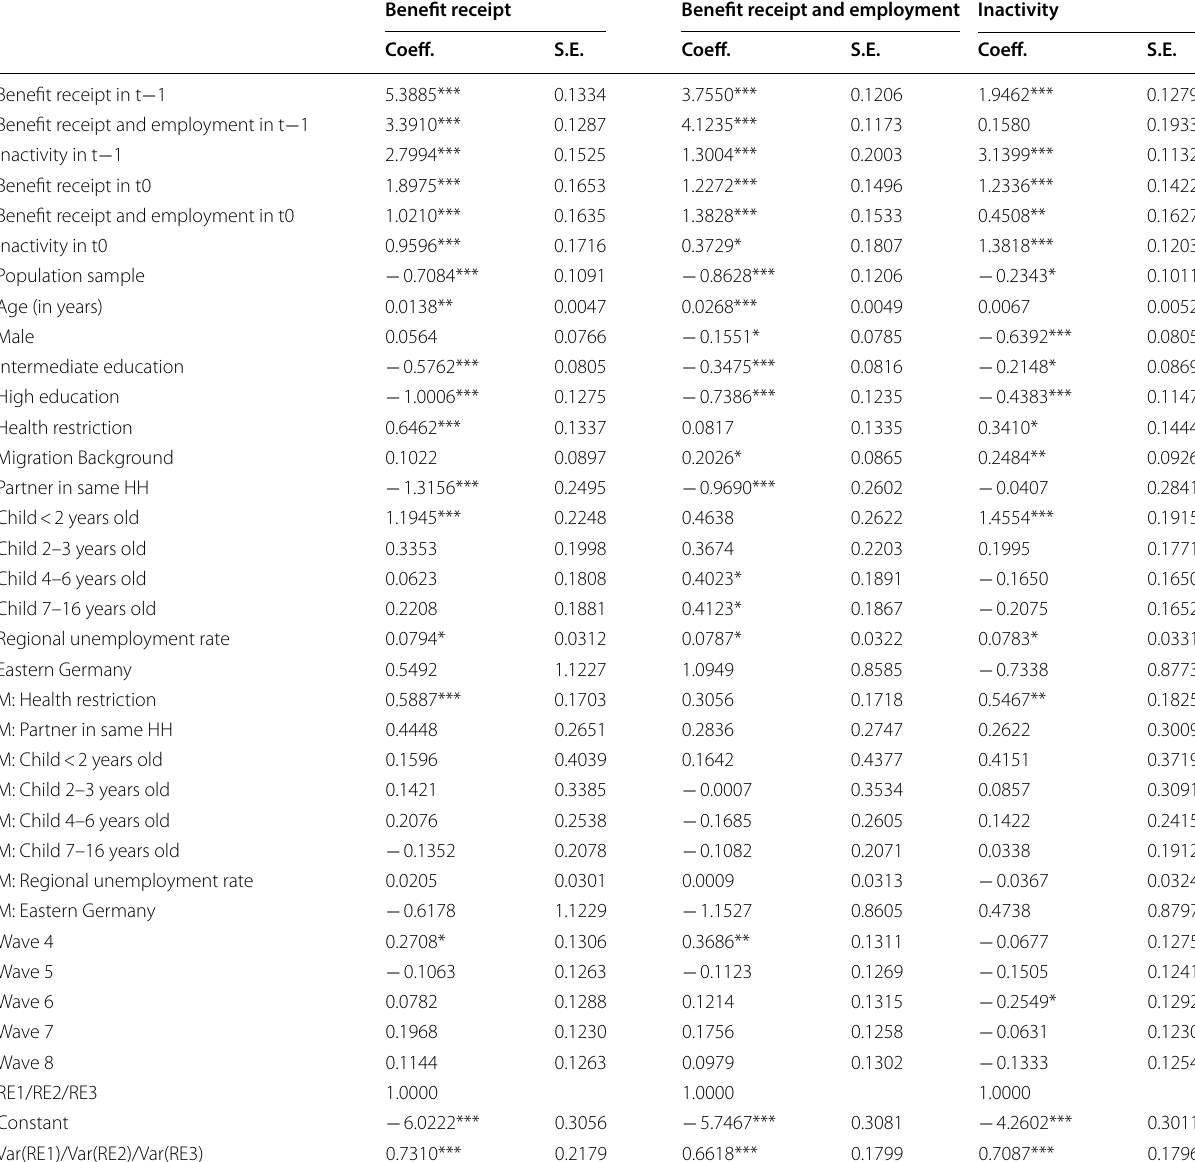
Table 11 Multinomial logit regression results (administrative data)—coefficients